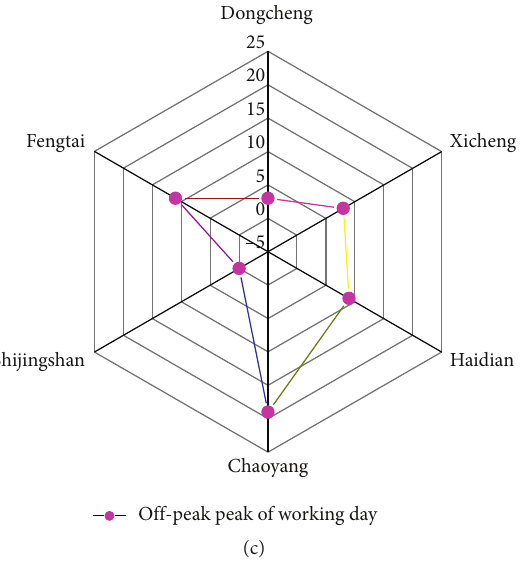
Figure 11: The distribution of key bus stations in different regions.